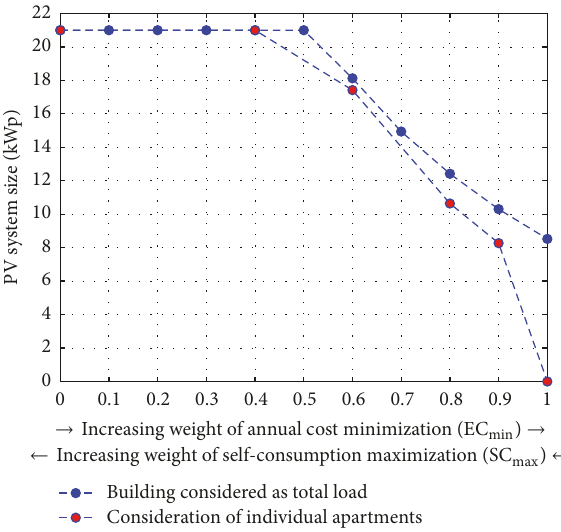
Figure 7: German retail electricity prices: optimal PV peak capacity installed and remaining electricity consumption from the grid.